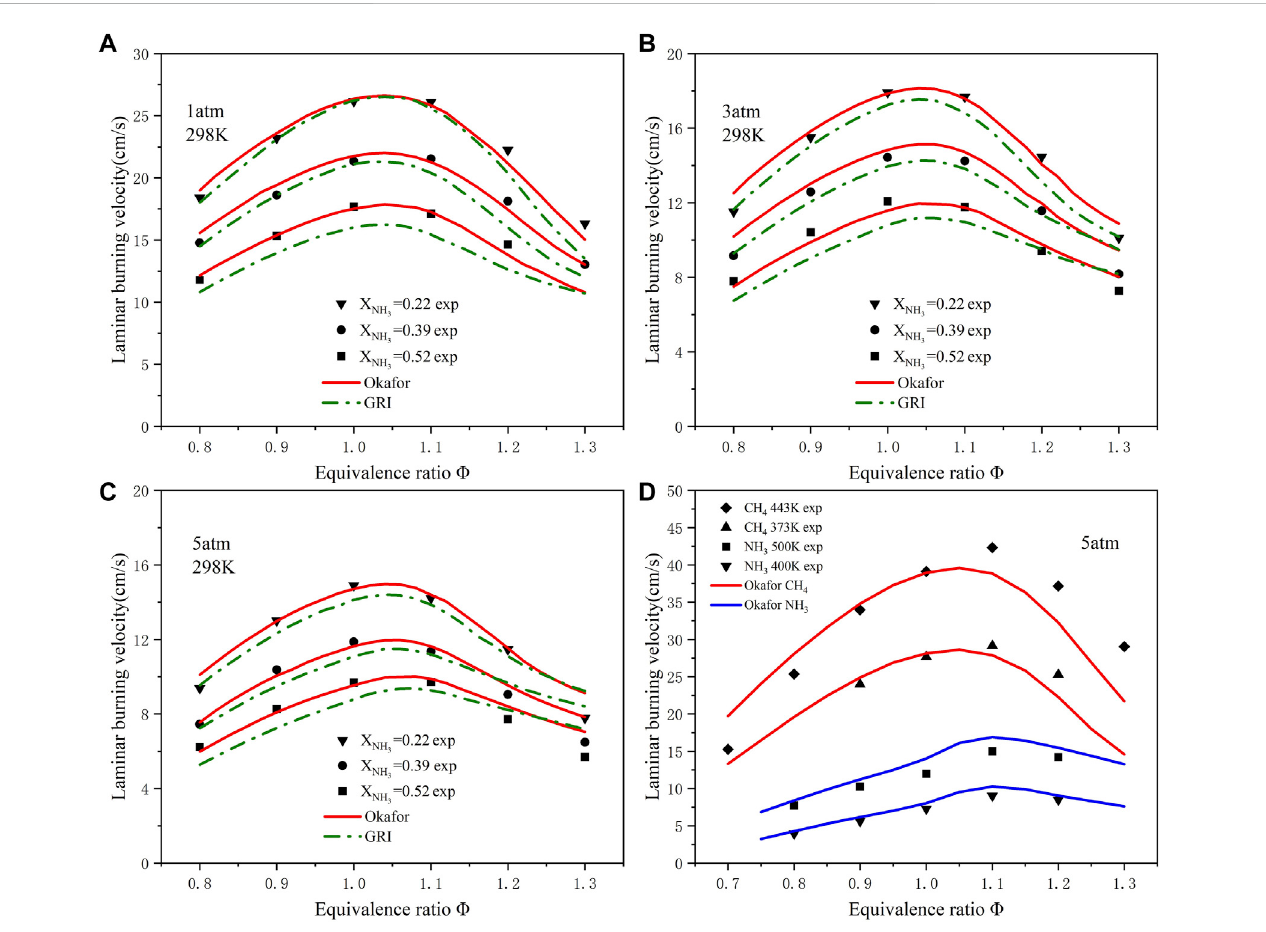
FIGURE 3 Comparison ofexperimentaland simulated LBVs atdifferentpressuresand initial temperatures: (A) T= 298 K, p = 1 atm; (B) T=298 K, p =3 atm; (C) T= 298 K, p = 5 atm; (D) When p = 5 atm, comparison of experimental and simulated LBVs of ammonia and methane at different initial temperatures. (Symbols: experimental data; lines: Simulated